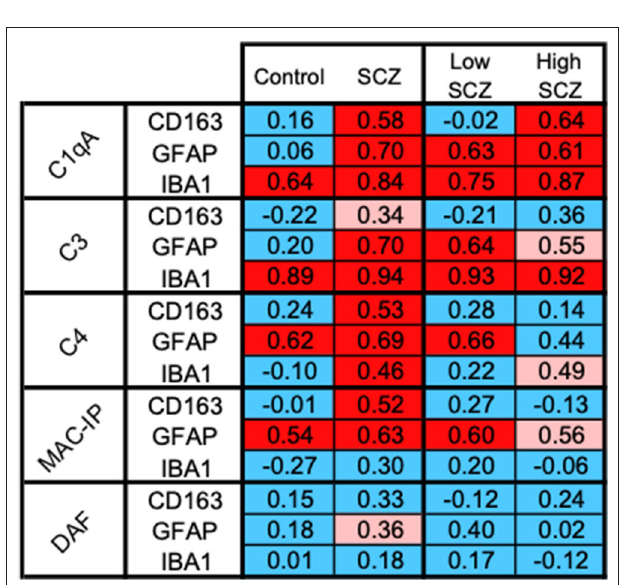
FIGURE 7 | CD163 + cells, the putative macrophages, may be the source of C1qA in the high inflammatory/schizophrenia subgroup. The pattern of positive correlations between CD163 and C1qA is distinguishable from the patterns indicating the relationships between the cell markers and other complement transcripts, suggesting a potentially important relationship between CD163 + infiltrating macrophages and C1qA transcripts in the high inflammatory/schizophrenia group. Blue boxes indicate no significant correlation, pink boxes indicate a trend toward positive correlations, and red boxes indicate positive